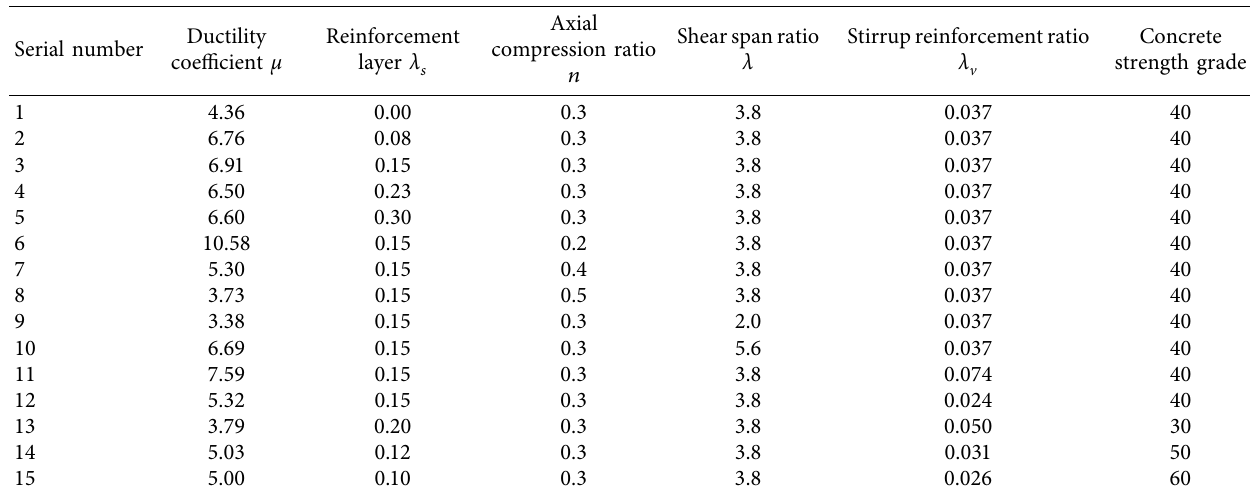
Table 9: Raw sample